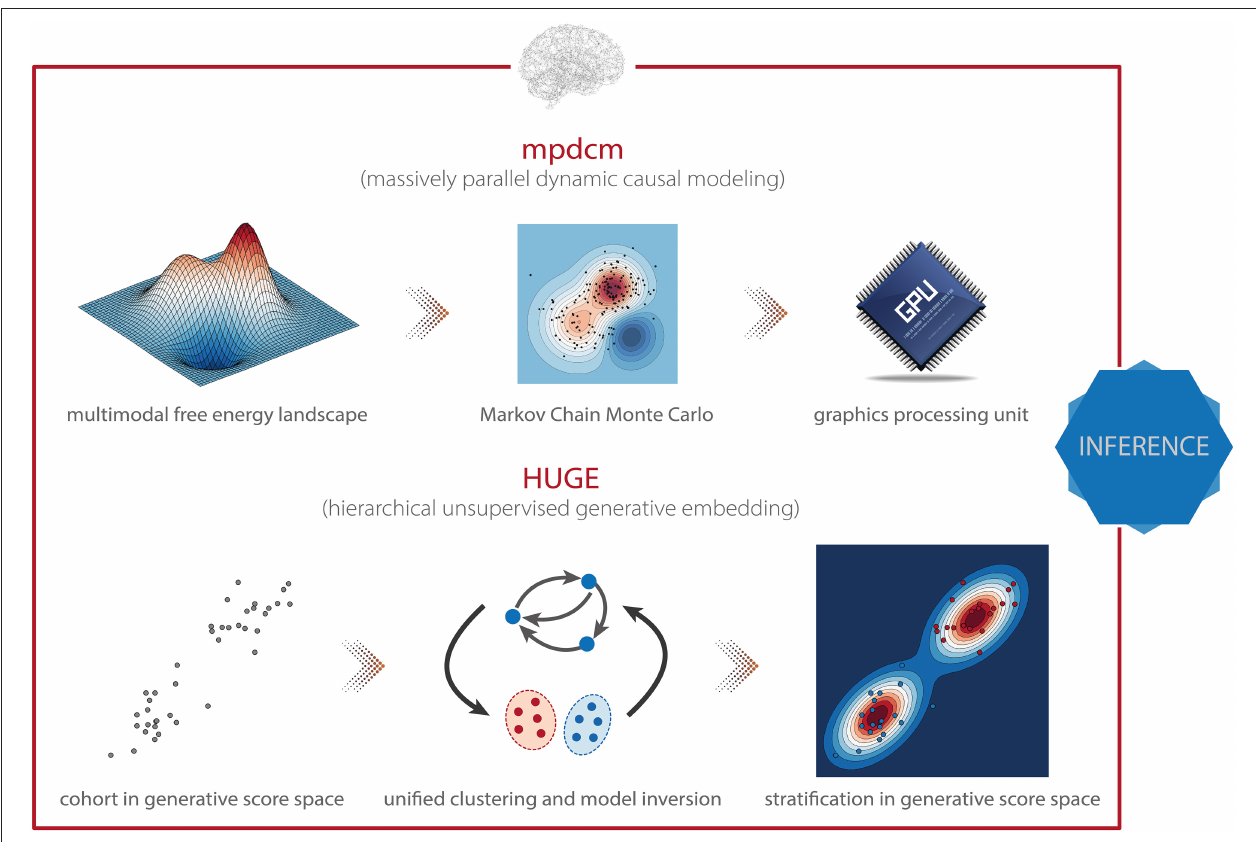
FIGURE 5 | TAPAS components that implement generative models of neuroimaging data (I). (Top) Massively parallel dynamic causal modeling (mpdcm) renders sampling-based model inversion computationally feasible by exploiting graphics processing units (GPUs). This allows one to obtain more faithful results in the presence of a multimodal optimization landscape. (Bottom) Hierarchical unsupervised generative embedding (HUGE) combines the inversion of single-subject DCMs and the clustering of participants into mechanistically homogenous subgroups within a single generative